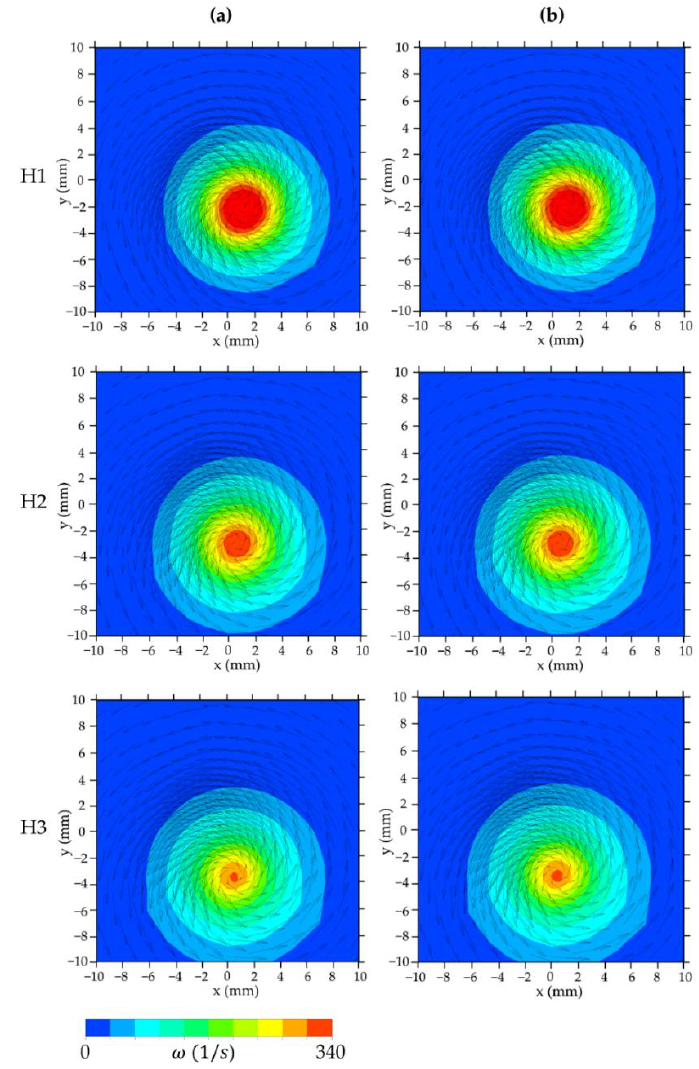
Figure 11. Velocity vectors represent the tangential projection of the average liquid velocity on horizontal planes for cases ( a ) C ent = 1 × 10 − 4 and ( b ) C ent = 2 × 10 − 4 . The background color represents the average liquid vorticity magnitude. The results are obtained from the simulations using C scale = 1. Horizontal planes H1, H2, and H3 are located 10, 20, and 30 mm above the bottom surface of the cylindrical vessel, respectively.